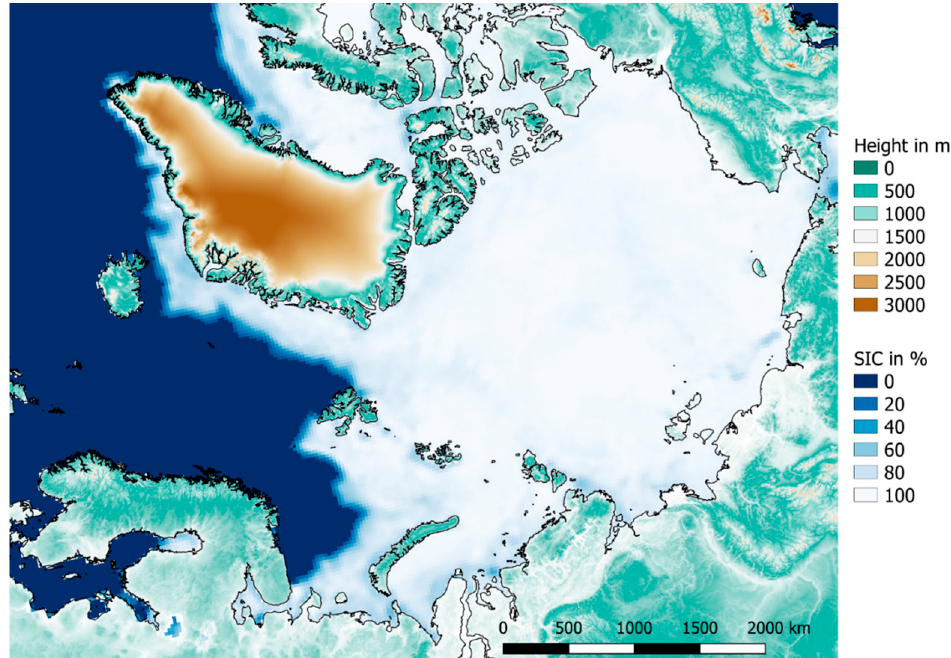
Figure 4. Domain of the CCLM 15 km model domain with topography and sea ice concentration (SIC) for 22 April 1997.